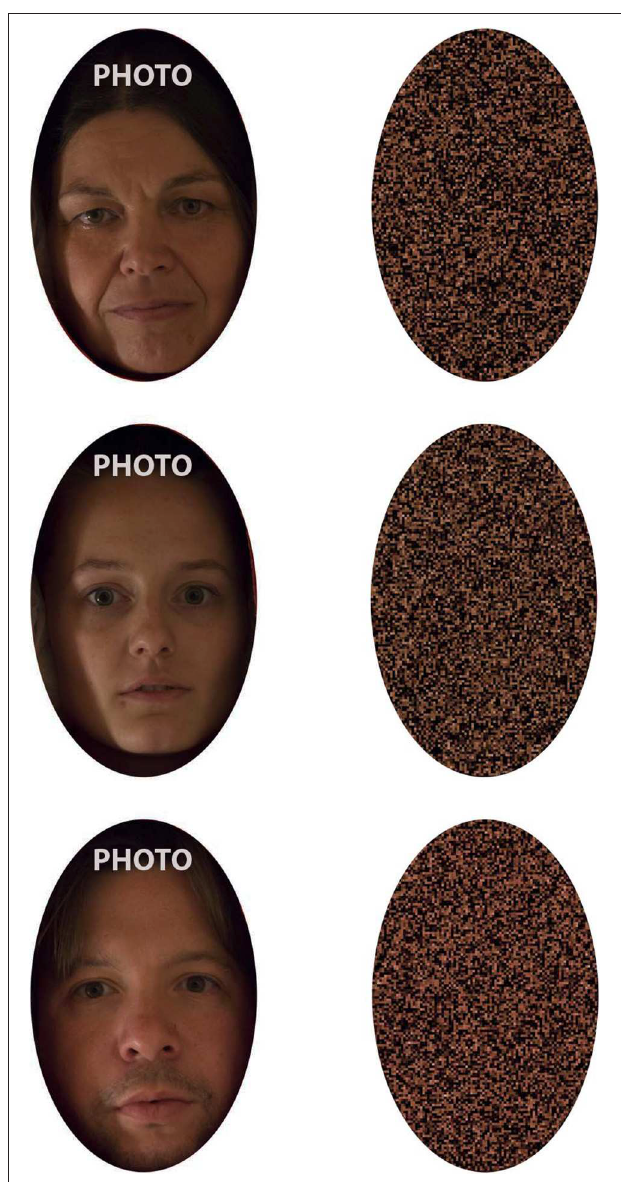
FIGURE 3 | Stimuli used in Study 2. Each stimulus set contained a live presentation, a portrait from the same individual, and the scrambled stimuli generated from the portrait. The individuals shown on the figure are authors of this paper and consented to the publication of their photographs. A video demonstrating stimulus presentation in Study 2 is available at the following link:(https://www.youtube.com/watch?v=tNaKRsG72b0).